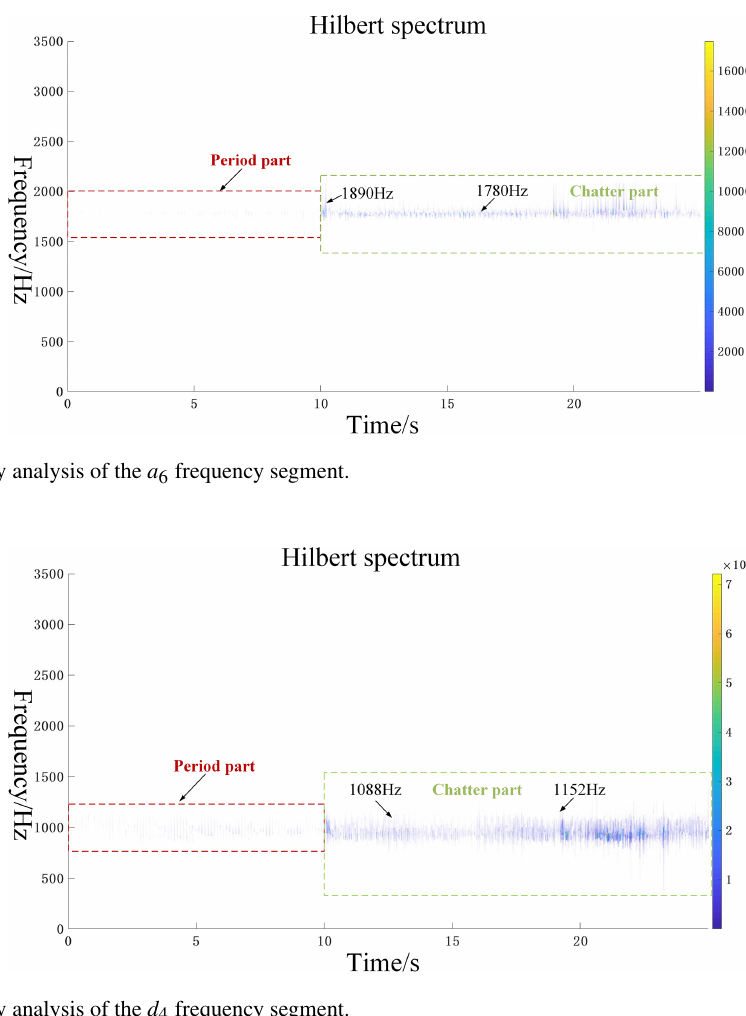
Figure 12. Time–frequency analysis of the d 4 frequency segment.